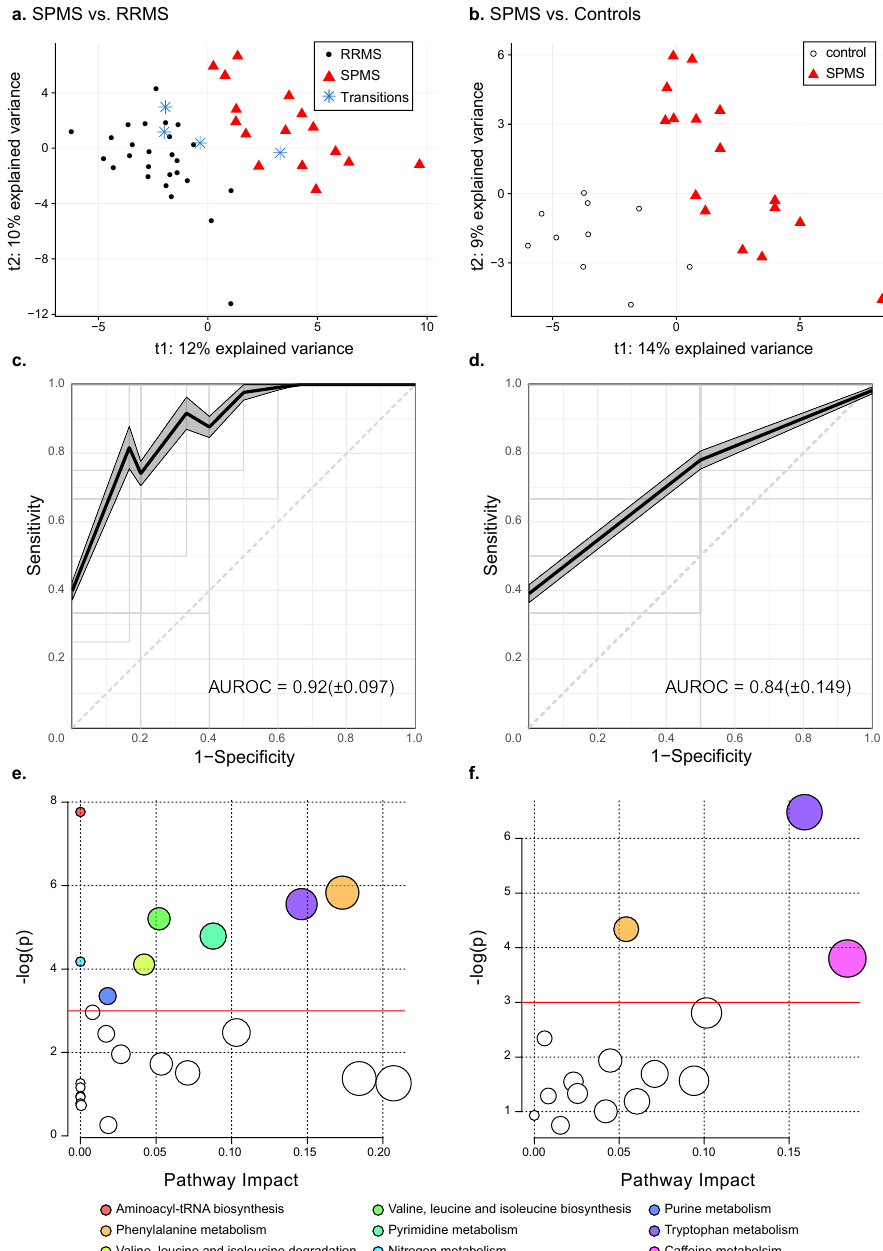
Figure 1. Metabolic differences in SPMS compared with RRMS patients and controls. PLS-DA models comparing ( a ) SPMS vs. RRMS with quality metrics of R 2 = 0.81: p < 0.05, Q 2 = 0.47: p < 0.05 and ( b ) SPMS vs. controls with quality metrics of R 2 = 0.85: p < 0.25, Q 2 = 0.34: p < 0.05. The projected transitioning RRMS patients are represented by blue stars. Average ROC curves with corresponding average AUROC and standard deviation for the PLS-DA models comparing ( c ) SPMS with RRMS and ( d ) SPMS with controls. The shadowed areas indicate the standard error of the mean of the sensitivity and 1-specificity. ( e ) Pathway analyses on altered metabolites in SPMS compared with RRMS patients, and ( f ) SPMS patients compared with controls. The size of the node indicates the pathway impact (similar to the x-axis) computed by the relative betweenness centrality and the color corresponds to the pathway. Pathways that were found non-significant in both comparisons have been colored white. The red lines indicate the significance level of p =